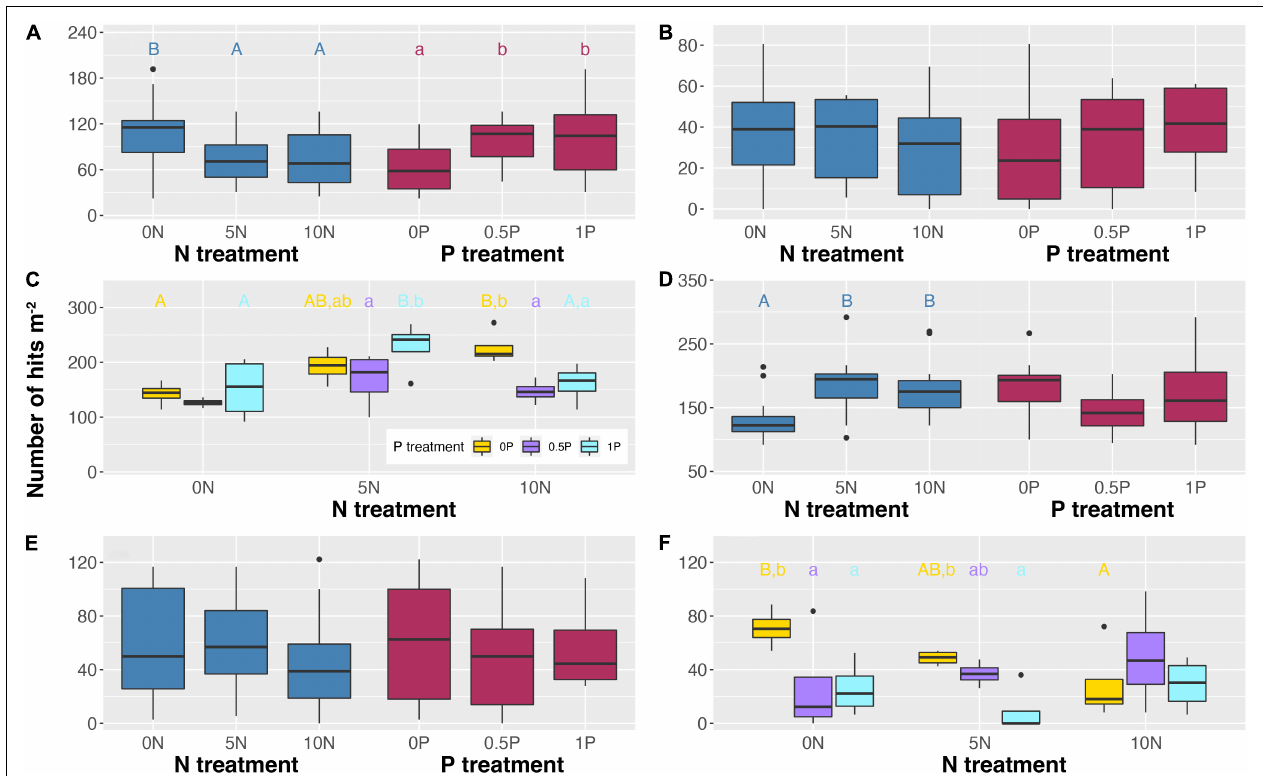
FIGURE 4 | Abundance of ericaceous shrubs (A) , ectomycorrhizal plants (B) , arbuscular mycorrhizal plants (C) , graminoids (D) , deciduous shrubs (E) , and cover of Sphagnum (F) in response to long-term N and/or P additions. When the interactive effect is not significant (A,B,D,E) , only main effects are shown. Different uppercase letters represent significant differences ( P < 0.05) among N treatments in (A,D) , and N treatments under the same P addition level in (C,F) . Different lowercase letters represent significant differences ( P < 0.05) among P treatments in (A) , and P treatments under the same N addition level in (C,F) . Treatment abbreviations as described in “Materials and Methods”